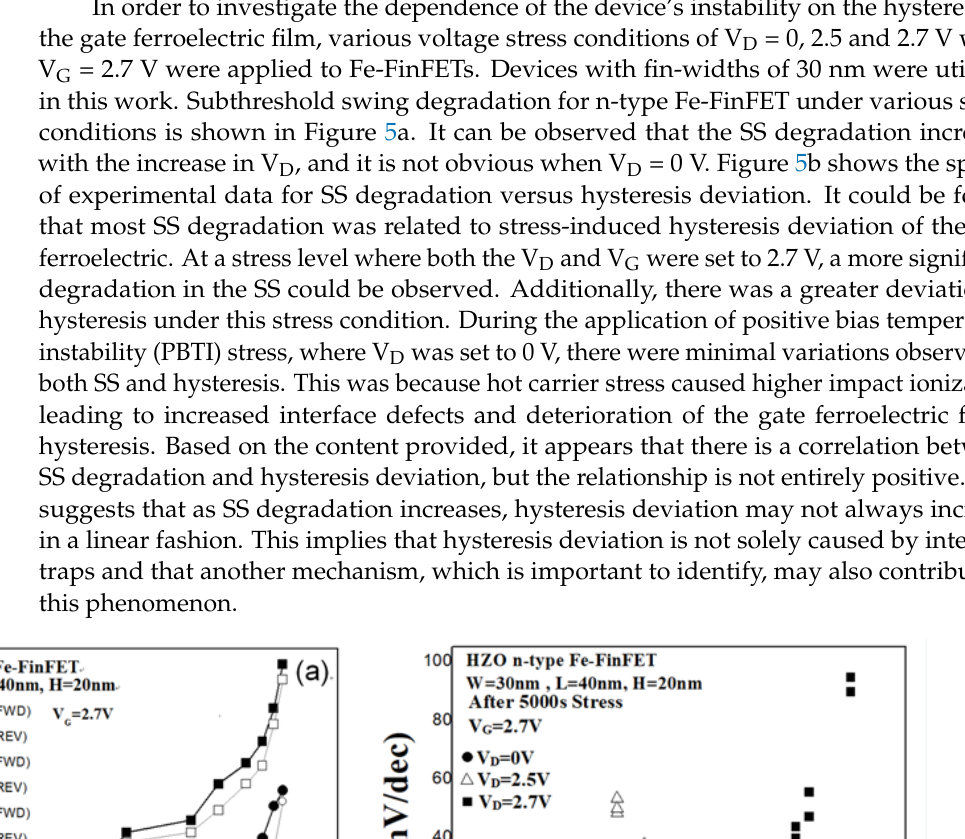
Figure 4. Hot - carrier - induced ( a ) subthreshold swing and ( b ) hysteresis degradations for various fin ‐ widths of n - type Fe - FinFET.